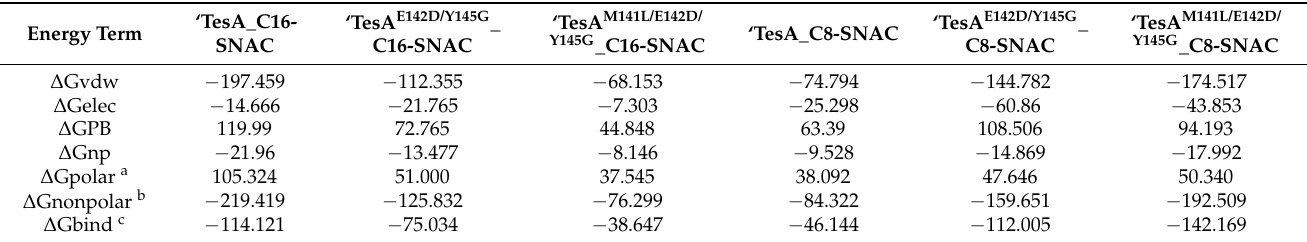
Table 2. Binding free energies and energy components calculated by MM/PBSA for the six complexes